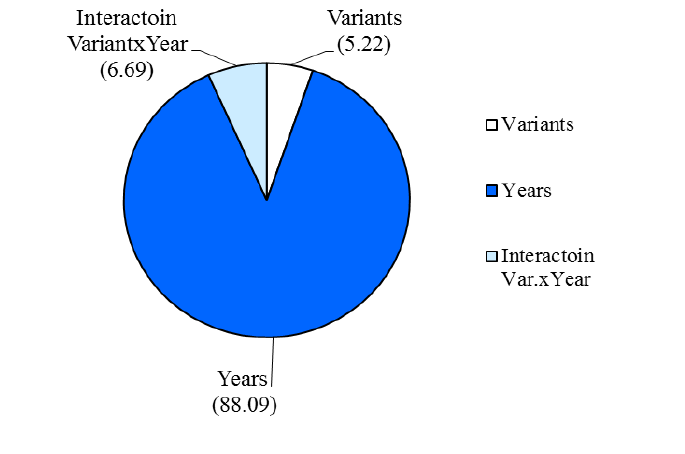
Fig. 1. Dry biomass productivity in different legume swards during 4-year growing period. Variants: V1-‘Pleven 6’, V2-‘Prista 2’, V3-‘Multifoliate’, V4-alfalfa local population LP1, V5-alfalfa local population LP2, V6-local population of birdsfoot trefoil, V7- local population of red clover; 1 st , 2 nd , 3 rd , 4 th – year of growing; cultivation of red clover during the 3rd experimental year was ceased due to the strong decrease of stand density